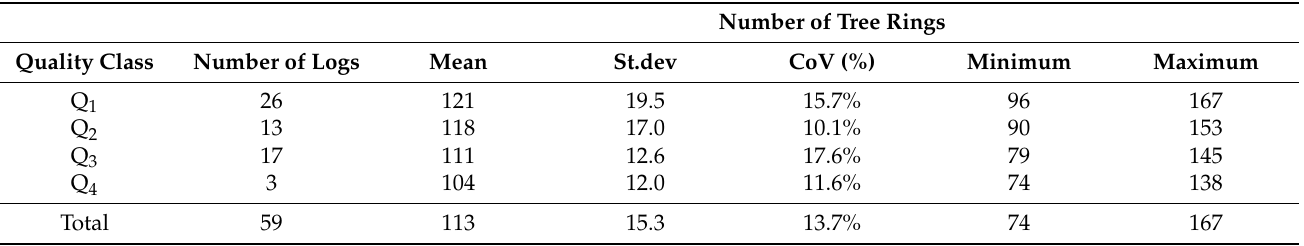
Table 2. Variation in number of tree rings in spruce logs of quality classes from Q 1 (highest) to Q 4 (lowest). St.dev—standard deviation; CoV—Coefficient of